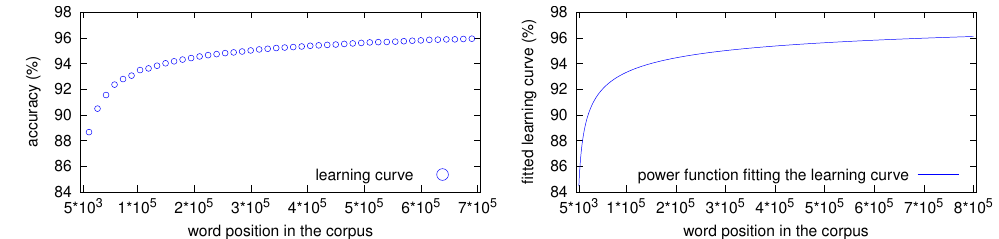
Figure 1. Learning curve for SVMT ool on X iada, and an accuracy pattern fitting it.